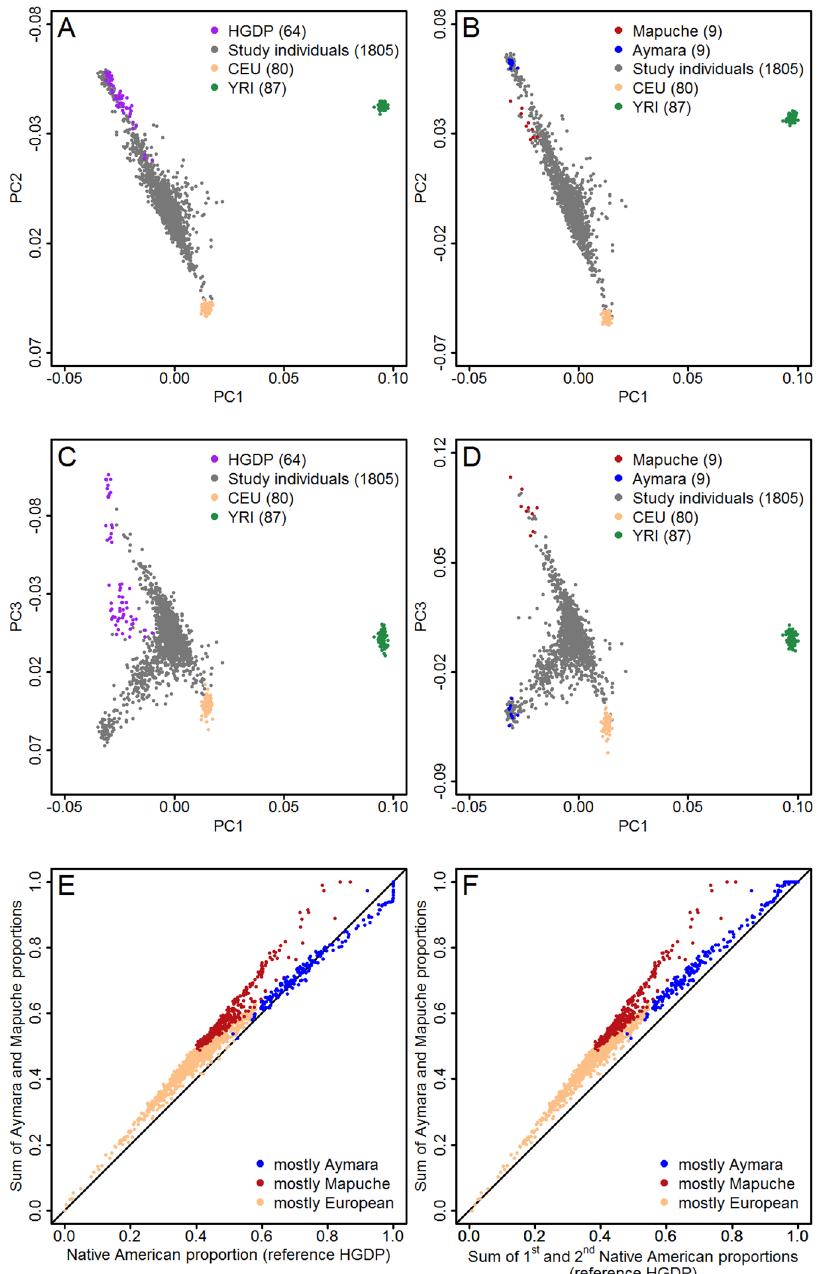
Fig 1. Genetic principal component analysesof individuals used in the aggregate-data study to investigate the relationship between the type of Native Americanancestry and disease-specific mortality risks (panels A-D), and scatter plots of estimated Native American proportions using different referenceindividuals as surrogates of Native American ancestry: 9 Mapuche and 9 Aymara referenceindividuals versus samples from the Americans in the Human Genome Diversity Project, supervised ADMIXTURE analysis (panel E) and unsupervised ADMIXTURE analysis with four ancestral populations (panel